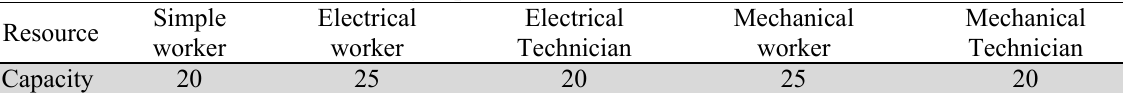
Available resources for the validating experiment